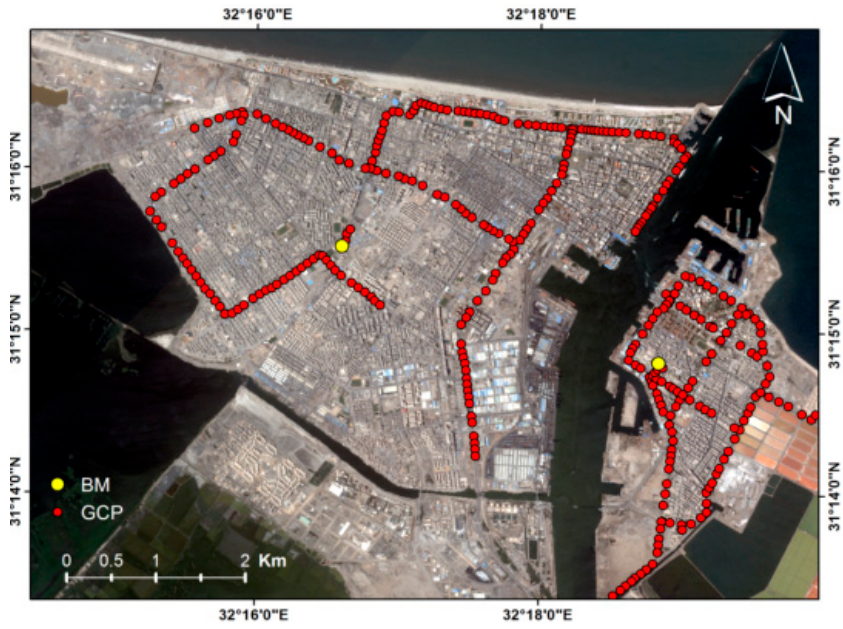
Figure 4. Two benchmarks (BM) were used as reference points for the 347 GCPs.